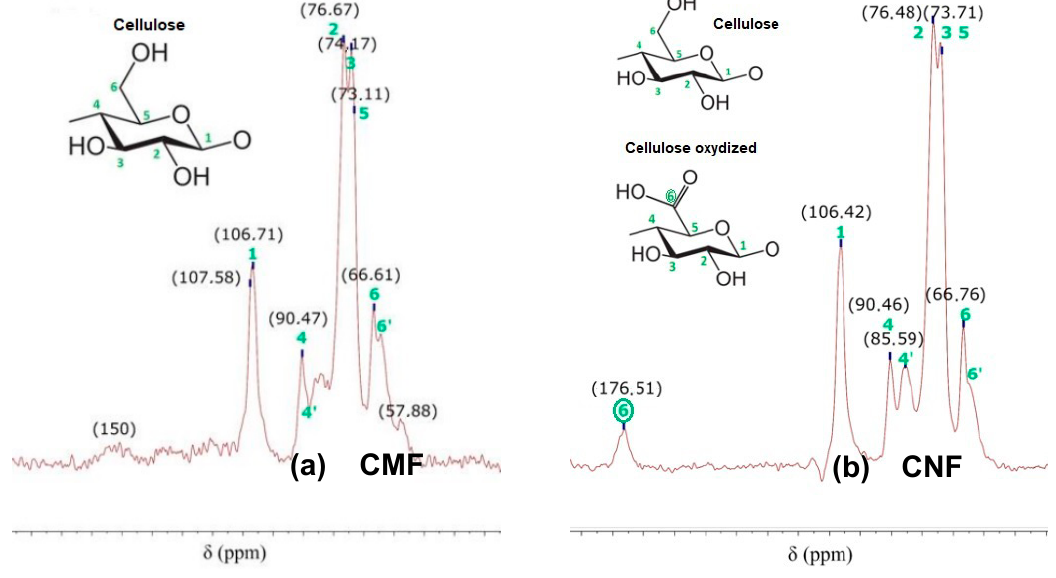
Figure 6. 13 C NMR spectra of ( a ) CMF and ( b )